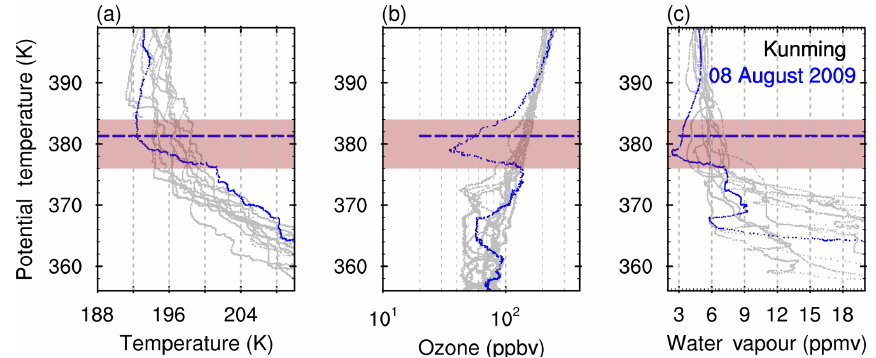
Figure 2. All vertical profiles of (a) temperature, (b) ozone mixing ratios (OMRs), and (c) water vapour over Kunming in August 2009. The profile on 8 August is marked as a blue line. The horizontal blue dashed line marks the lapse-rate tropopause on 8 August. The shaded region denotes the low ozone and low water vapour mixing ratios region.